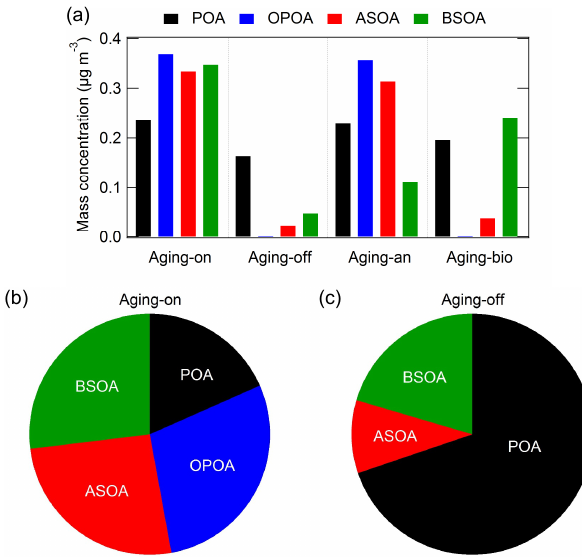
Figure 8. Period-averaged (24 March–26 April 2009) mass concen- trations of POA, OPOA, ASOA, and BSOA at an altitude of about 1km over the outer domain for Aging-on, Aging-off, Aging-bio, and Aging-an simulations (a) . Period-averaged fraction of POA, OPOA, ASOA, and BSOA to total OA mass concentrations at an altitude of about 1km over the outer domain for simulations with (b) or without (c)